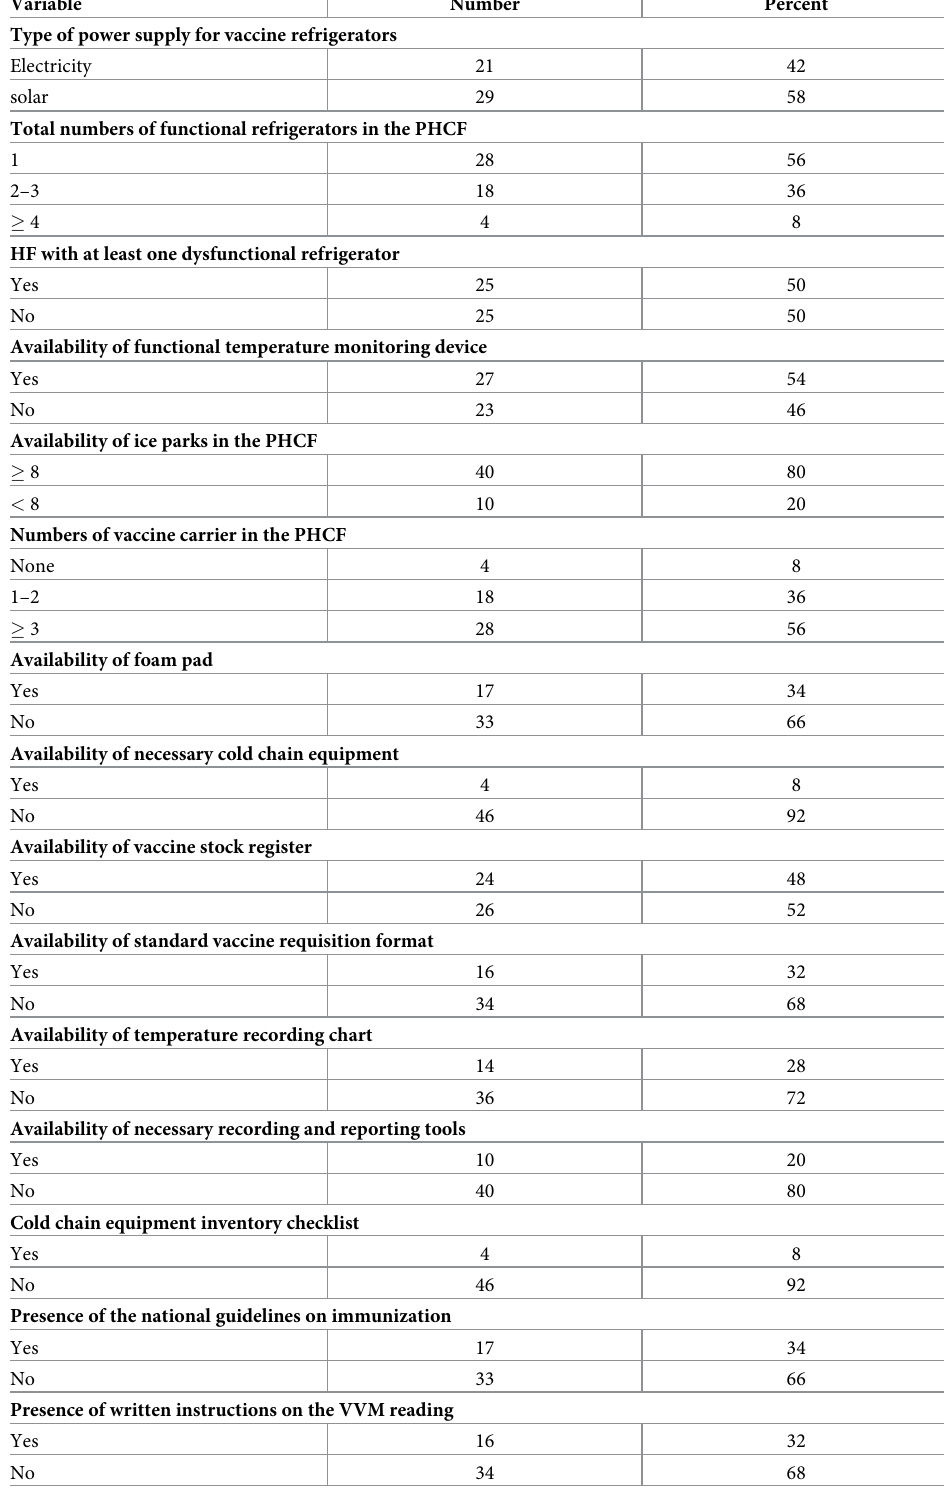
Table 4. Availability of infrastructure and cold chain equipment in primary health care facilities of Tigray region, Northern Ethiopia, 2019 (N =